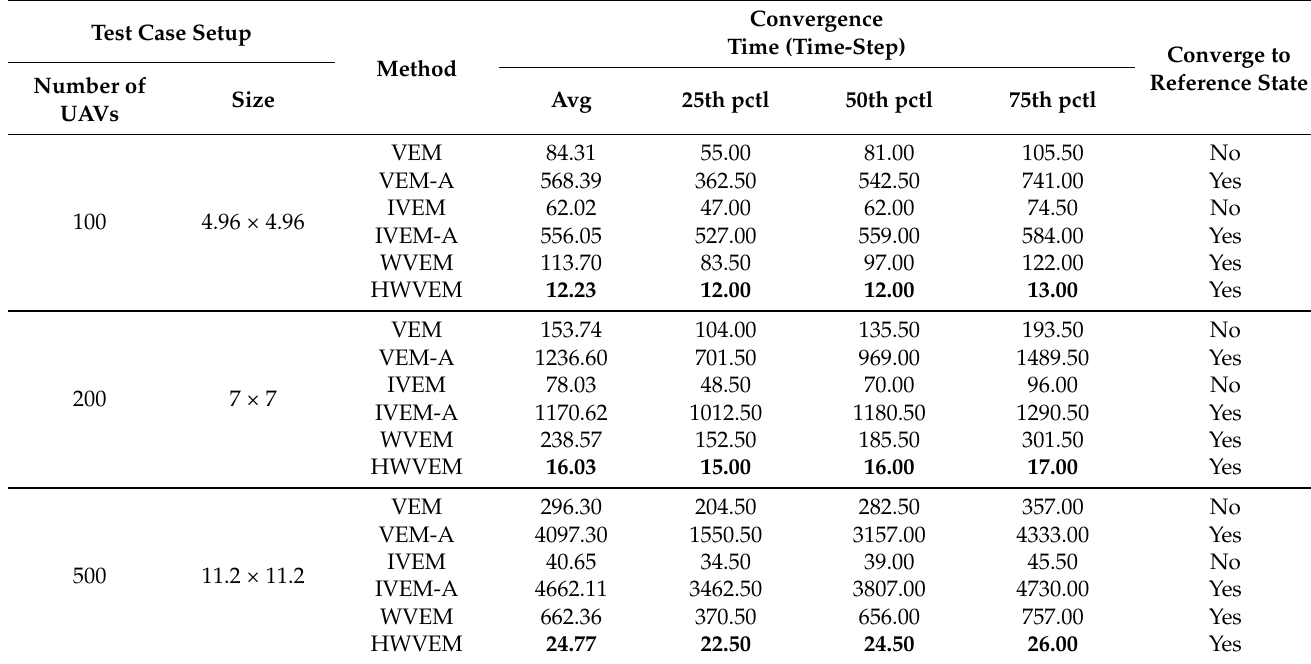
Table 1. The alignment performance of VEM, VEM-A, IVEM, IVEM-A, WVEM and